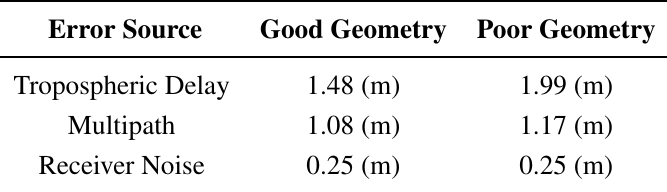
Table 1. Error budget for the simulation.